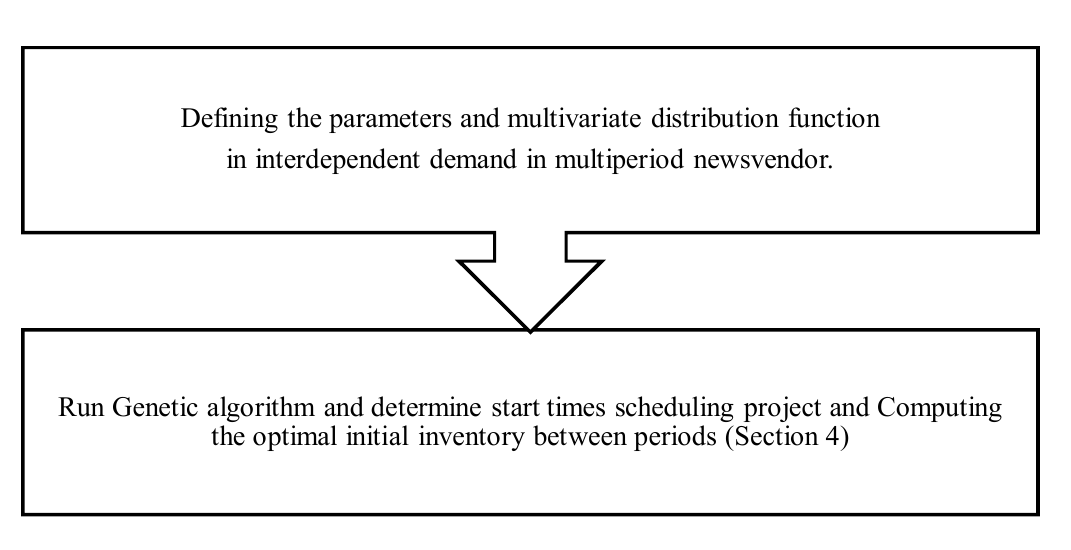
Fig. 1. Process of implementation of the conceptual